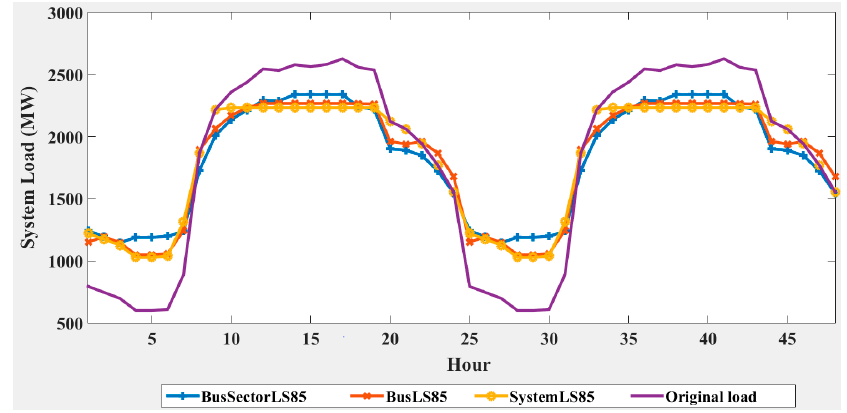
Figure 5. The 48-h system load profile with 85% pre-specified peak.